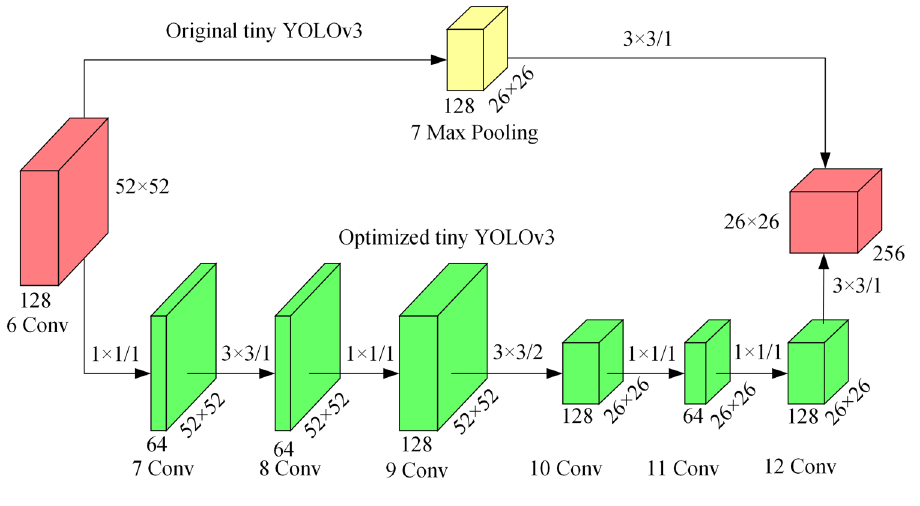
Figure 2. Enhancement